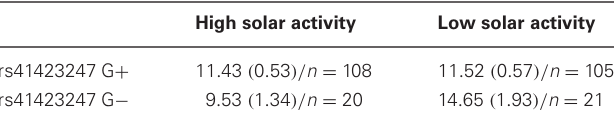
Table 3 | Interaction effect of rs41423247 (G ± ) by solar activity in the first trimester (high/low) on neuroticism (means and SEM are presented).